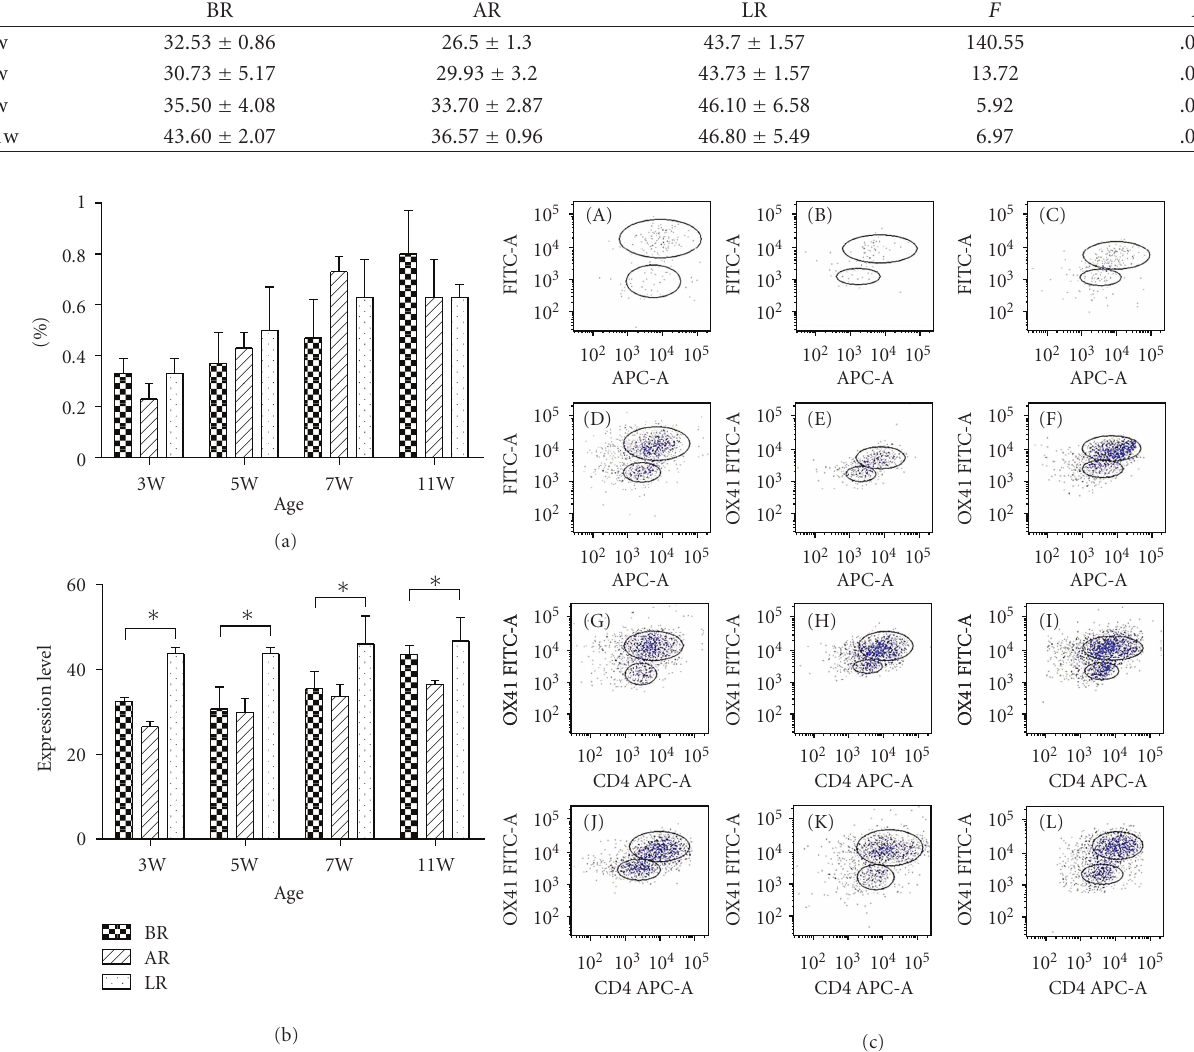
Table 3: The express level of the OX62 + CD4 + SIRP + intestinal DC of each group in di ff erent development stages (Mean ± SD) ( N = 5). BR AR 3w